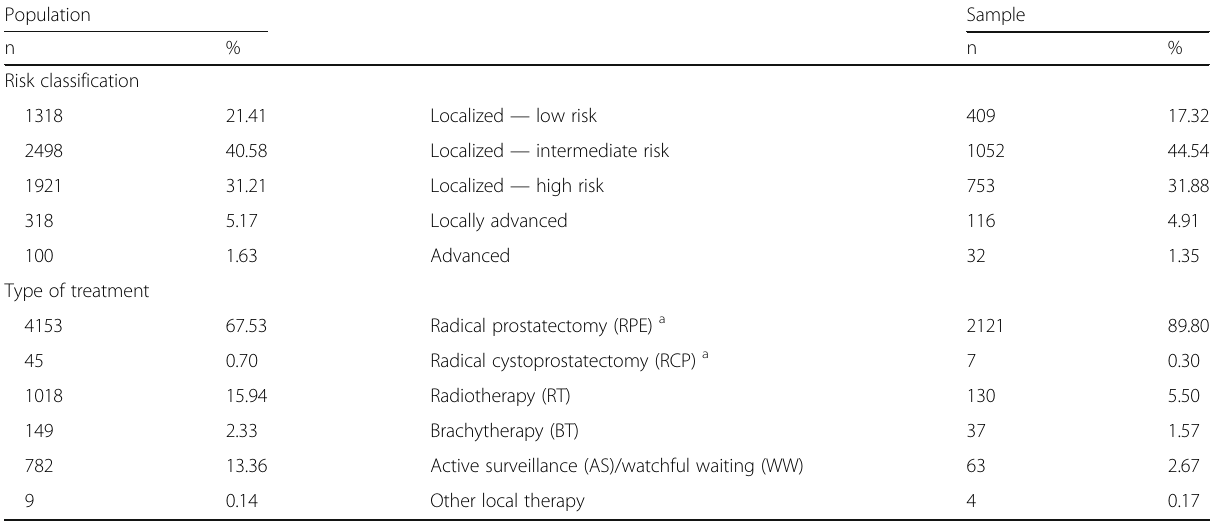
Table 2 Patient recruitment relative to risk classification and type of treatment Population